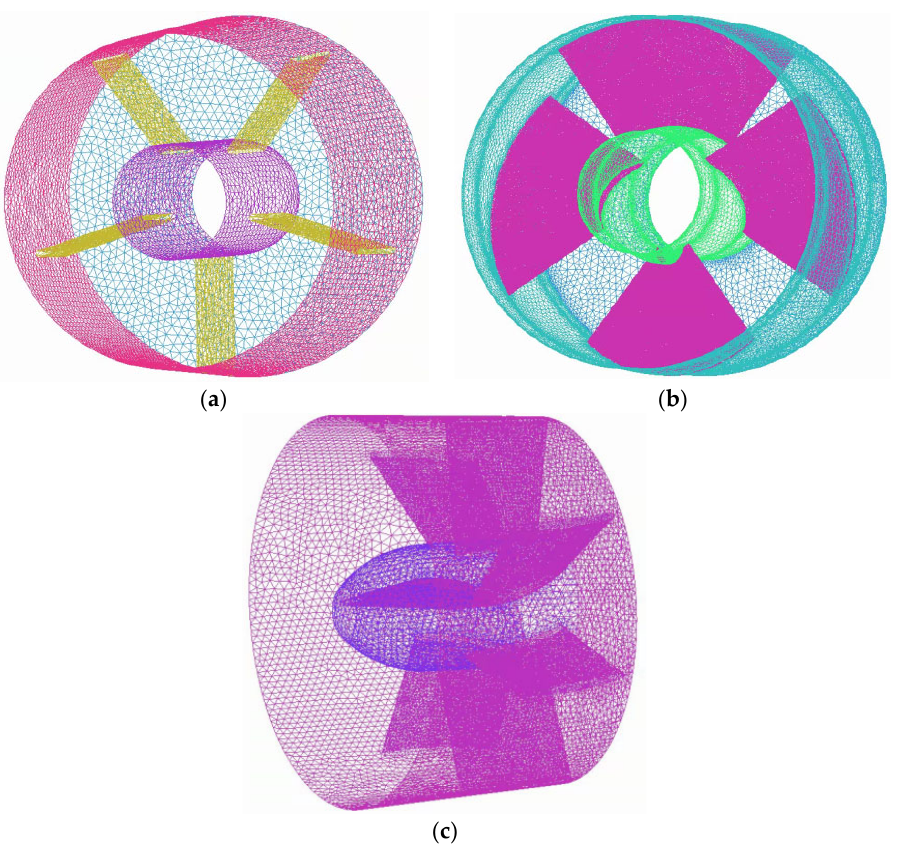
Figure 3. Unstructured mesh in some regions of the axial flow pump in the flow field. ( a ) Front guide vane area. ( b ) Turbine blade region. ( c ) Active guide vane region.